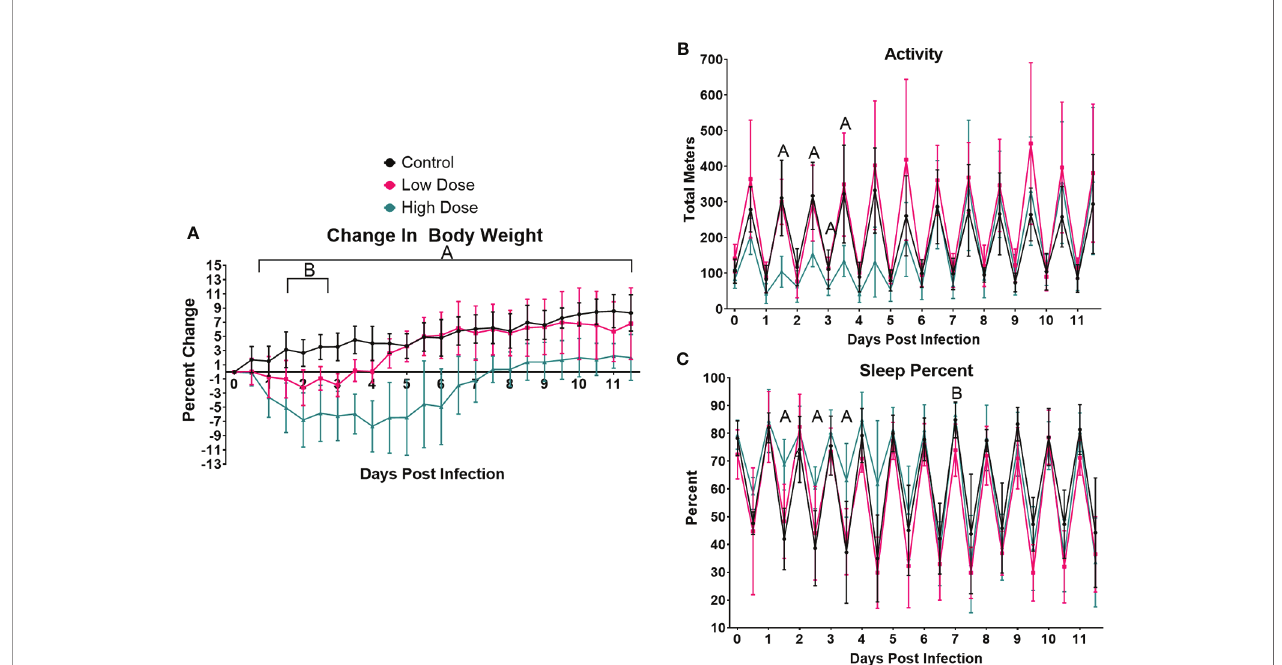
FIGURE 1 | Infection-induced weight loss and lethargy. Analysis of change in (A) body weight (B) activity, or (C) sleep over the 12-day experimental period. For each parameter, the values were averaged for each individual mouse over the 12-h light/dark cycle. Each data point represents the combined average of the fi ve animal group over a 12-h light/dark cycle. Signi fi cance was assessed using one-way ANOVA followed by a Dunnett Test for multiple comparison. Data are represented as mean ± SD. A indicates a signi fi cant between High Dose - Control and B indicates a difference between Low Dose - Control at a p =/< 0.05. Control (n = 6), High Dose (n = 5), Low Dose (n =